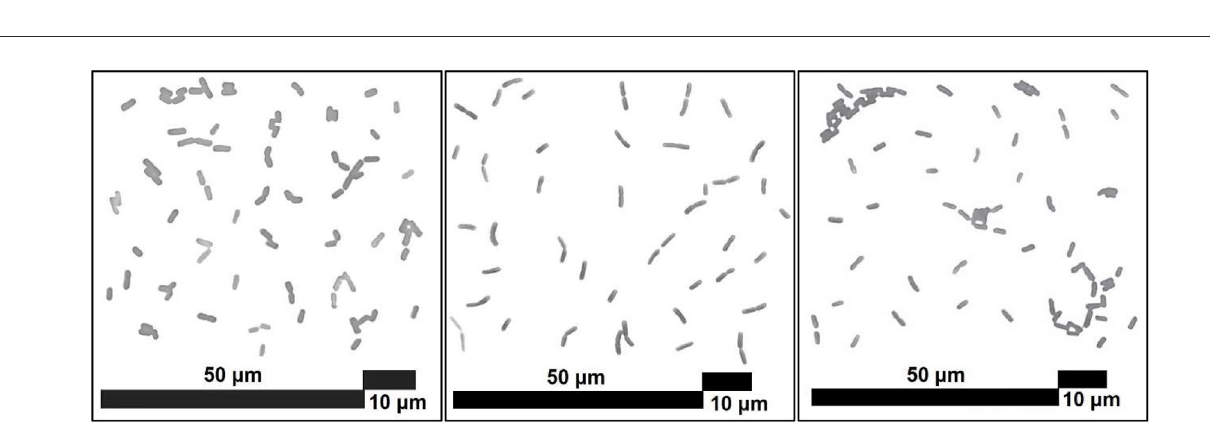
Since no bacteria of the genus Fructobacillus or Fructilactobacillus were found in the research carried out by Torres-Moreno et